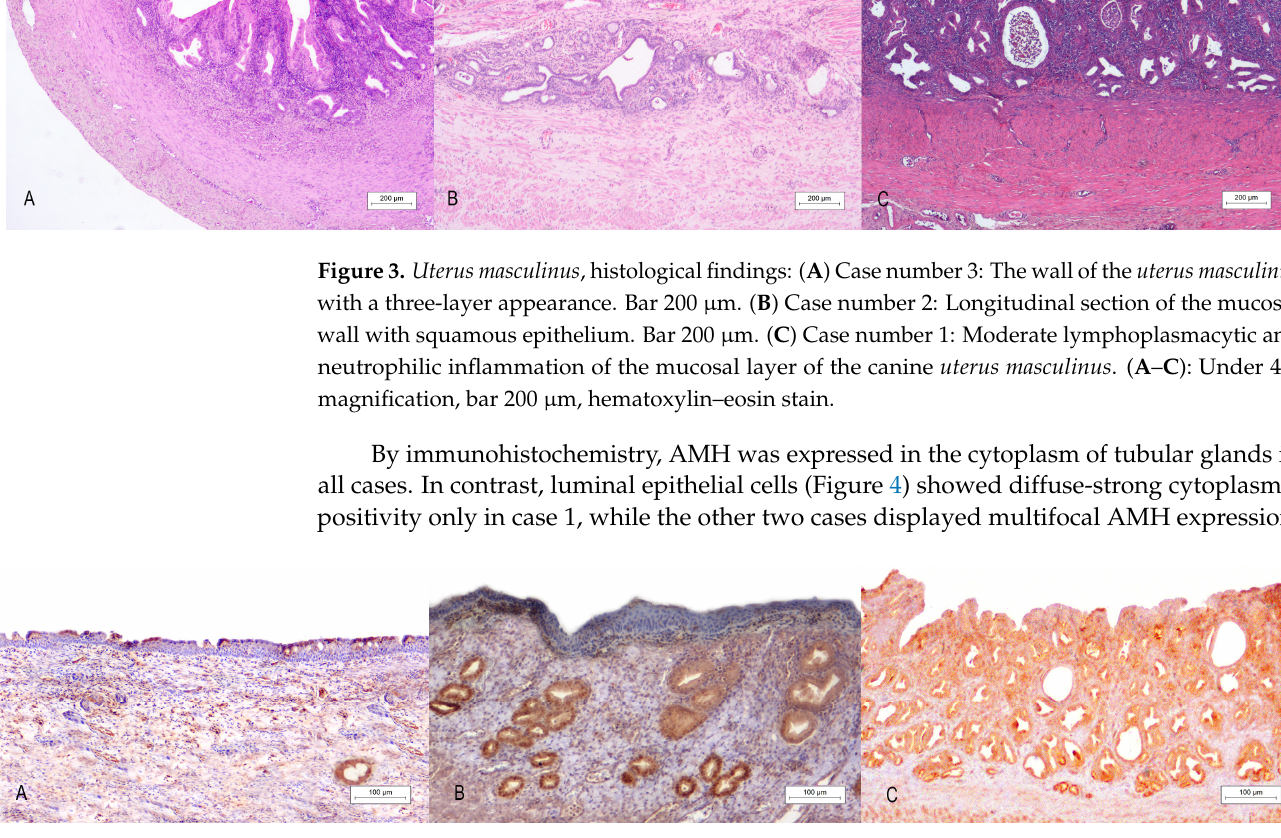
Figure 4 . Uterus masculinus , immunohistochemical findings: ( A ) Case number 3: Multifocal- cytoplasmic AMH staining in the simple columnar epithelium of the uterine mucosa. Bar 100 µm. ( B ) Case number 2: Diffuse-negative immunolabelling of the uterine squamous epithelium and simultaneous strong glandular expression of AMH. Bar 100 µm. ( C ) Case number 1: Diffuse-strong glandular and epithelial AMH immunolabelling. ( A – C ): Under 10× magnification, bar 100 µm.